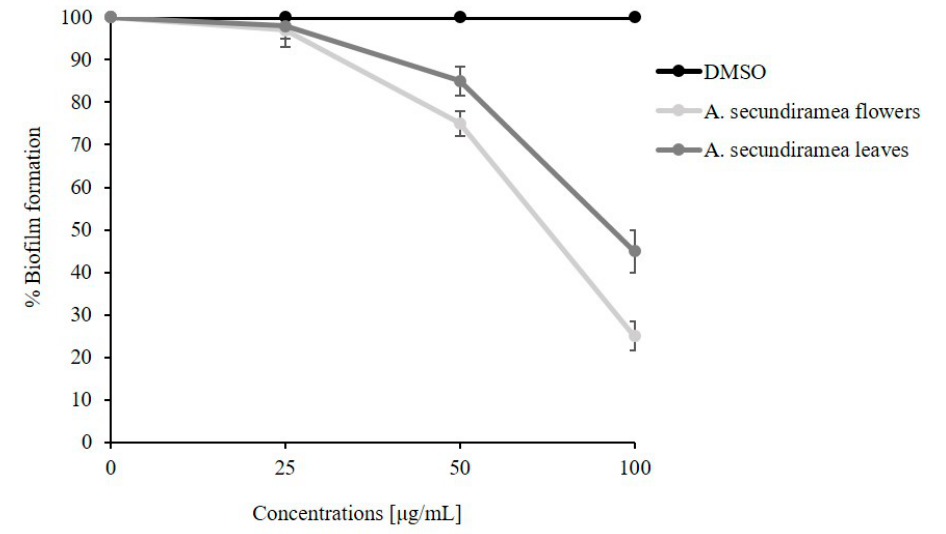
Figure 6. Colorimeter assay to evaluate the formation of P. aeruginosa PAOI biofilm with different oil concentrations (0, 25, 50, 100 µ g / mL). The negative control is represented by cells treated with the DMSO (2%), and the positive control is represented by untreated cells. Values are expressed as the average of three different experiments; standard deviations were always less than 10%.